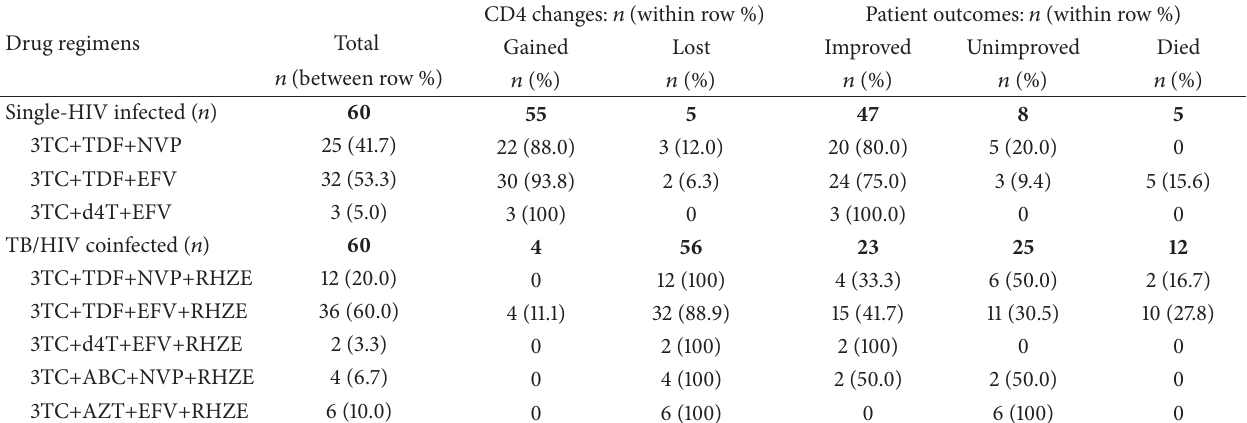
Table 2: Frequency of types of regimen prescribed and their clinical outcomes.